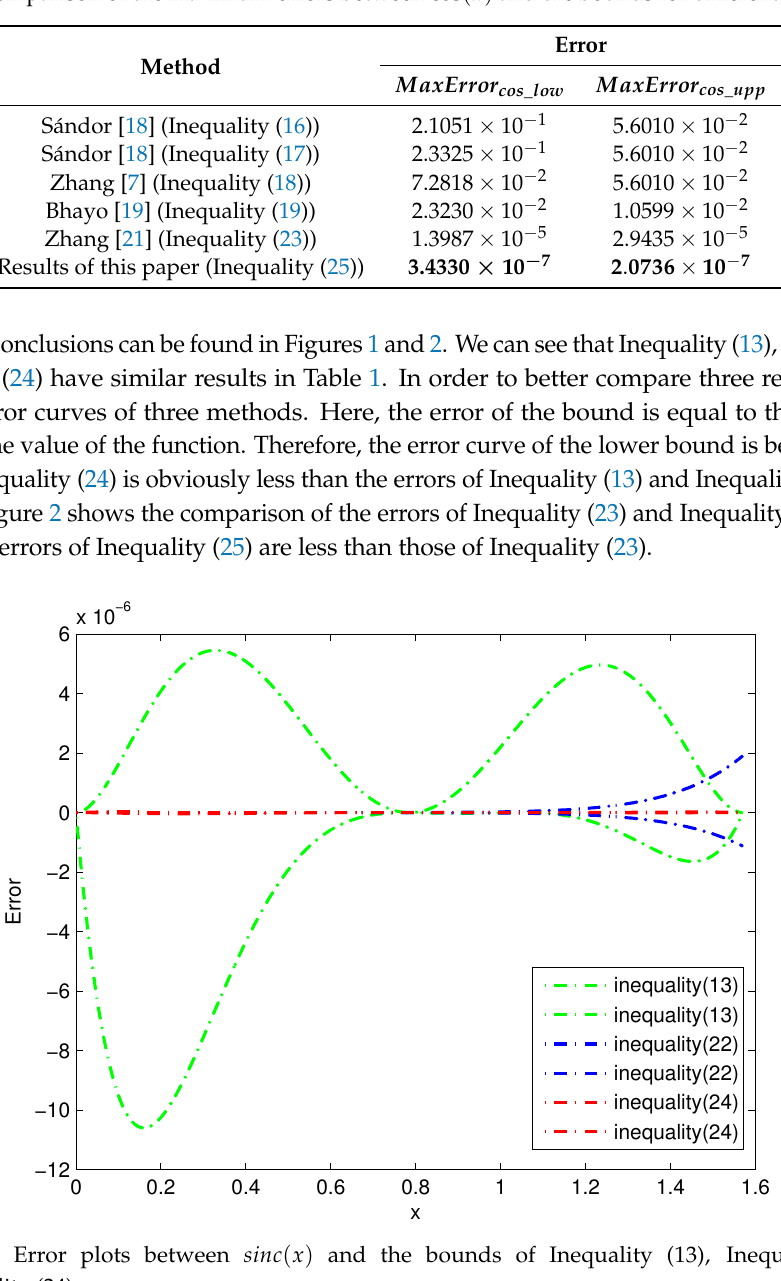
Table 2. Comparison of the maximum errors between cos ( x ) and the bounds for different methods.